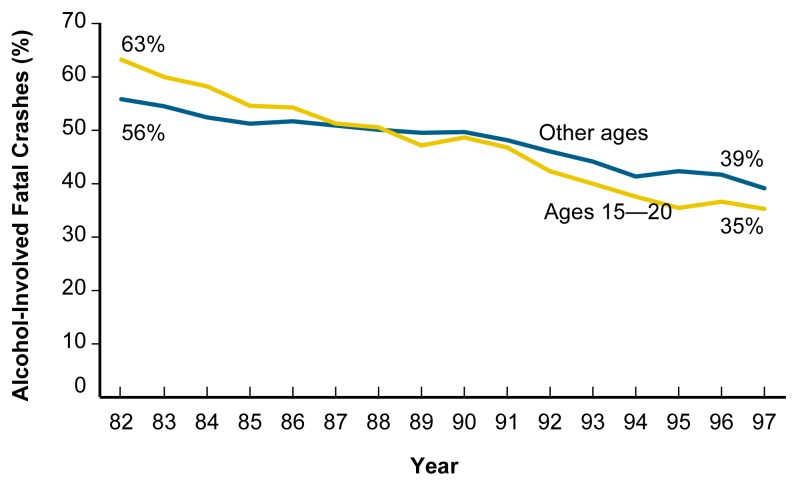
Proportion of fatal crashes that involved alcohol, 1982 to 1997. Since 1982 the proportion of fatal crashes that involve alcohol has steadily declined.SOURCE: National Highway Traffic Safety Administration 1998a.